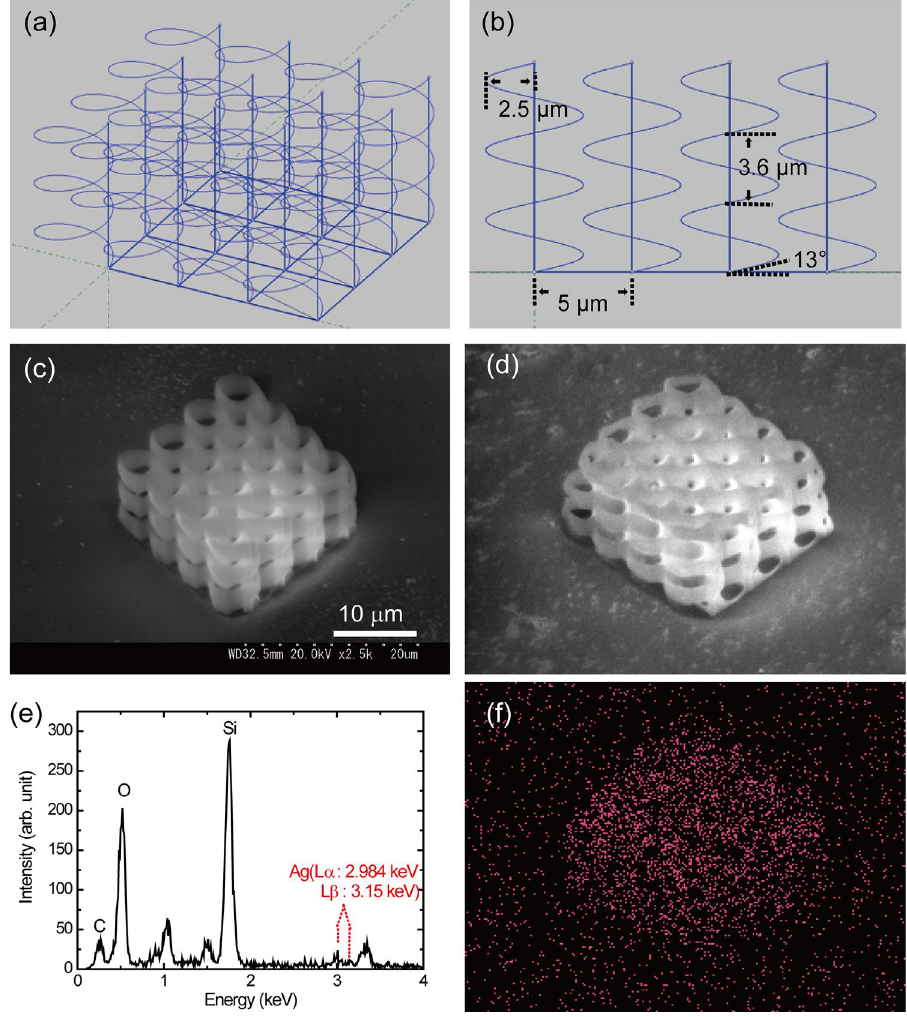
Figure 4. ( a ) Programmed pattern of a helical structure with a radius of 2.5 μm and an elevation angle of 13°. ( b ) Cross section of the programmed pattern shown in ( a ). ( c ) SEM image of fabricated helical structures using the programmed pattern in ( a ) before electroless silver plating. ( d ) SEM image of the fabricated helical structures after electroless silver plating. ( e ) EDX spectrum of the fabricated structure with silver plating. ( f ) EDX image of Ag in the fabricated helical structure with silver